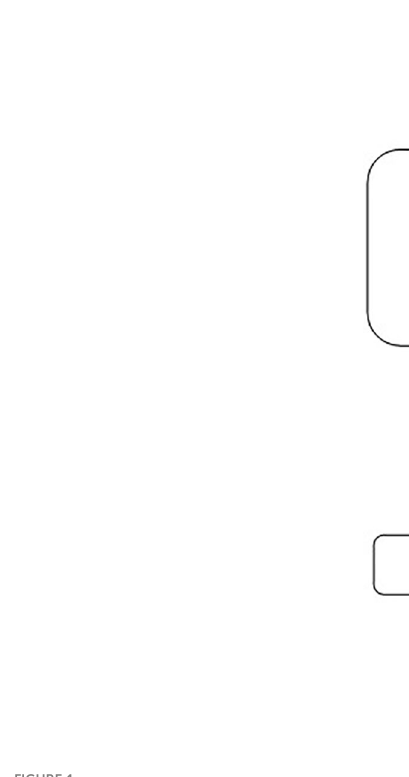
FIGURE 1 Flowchart presenting patient